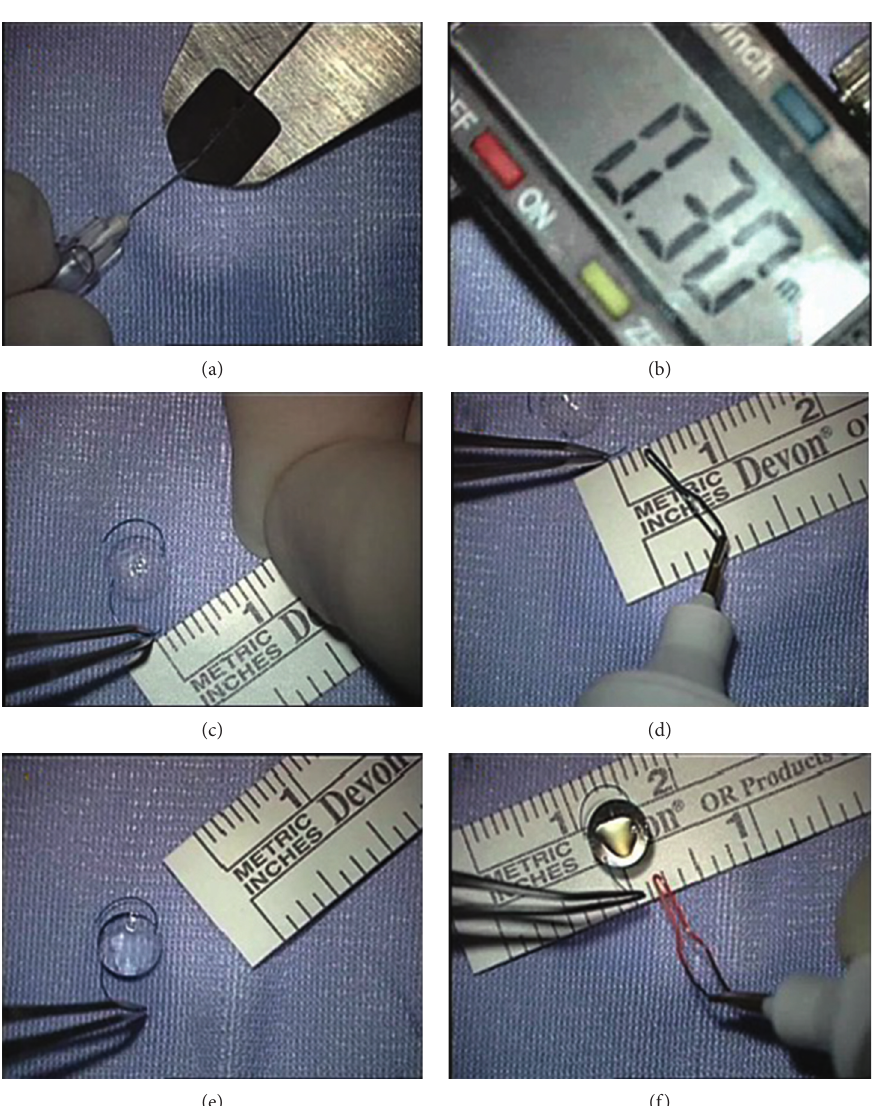
Figure 1: A professional ruler was used to measure the external dimension of the 30g UTW needle and blocked in that position (a, b) in order to measure the internal dimension of the scleral tunnel. Forceps was put at 1mm and 2 mm (c, d) from the tip, and the tip was heated from distance until the plug reached the forceps (e,